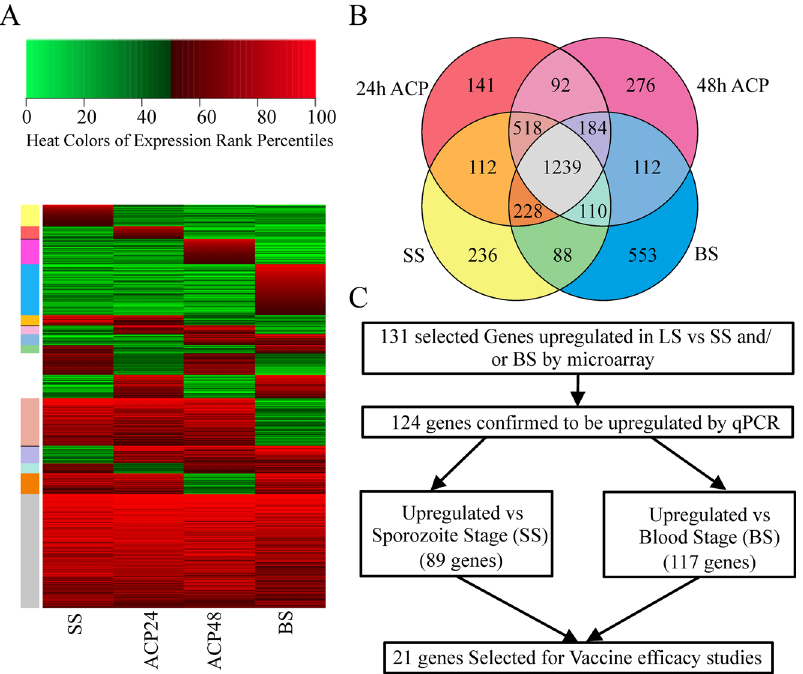
Fig 1. Gene expression profile of Pf genes and selection algorithm used for antigen selection. (A) Heat map of gene expression by tiling microarray. Red color represents the genes expressing above the 50 th percentile, while green color represents genes expressing below the 50 th . The heat map shows the expression profile of genes across SS, 24h and 48h axenically cultured LS, and BS parasites. (B) Venn diagram shows stage-specific expression of genes by tiling microarray. Color coding of Venn regions matches the color bar provided for the heat map in Panel A. (C) Selection of genes for vaccine evaluation in two rodent models. One hundred and thirty-one genes were selected from among the upregulated genes identified by tiling-microarray, and 124 were confirmed by qPCR to be transcribed at higher levels in LS versus SS and/or BS parasite samples. Twenty-one of these 124 genes were selected for further evaluation as vaccine